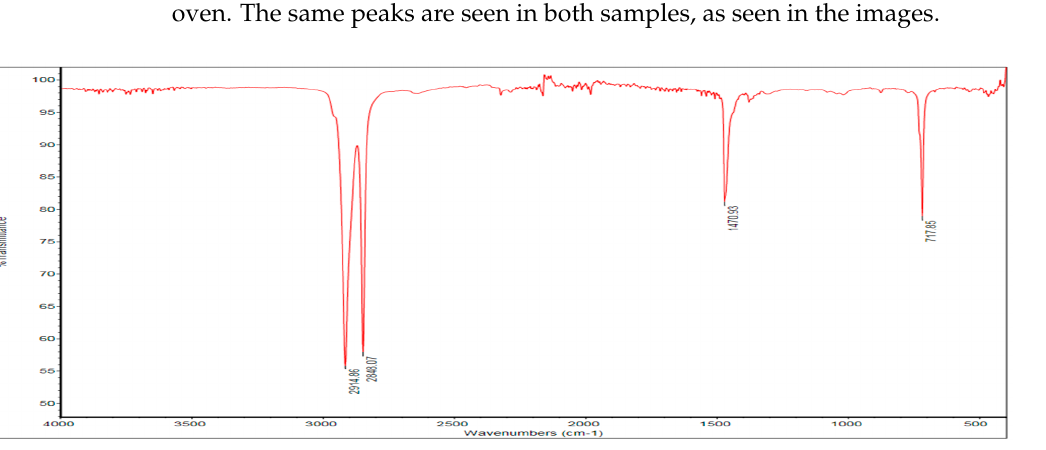
ChemEngineering 2023 , 7 , x FOR PEER REVIEW Figure 10. FTIR analysis of LLDPE after the addition of 1% weight of pro-oxidant additive at day 0.